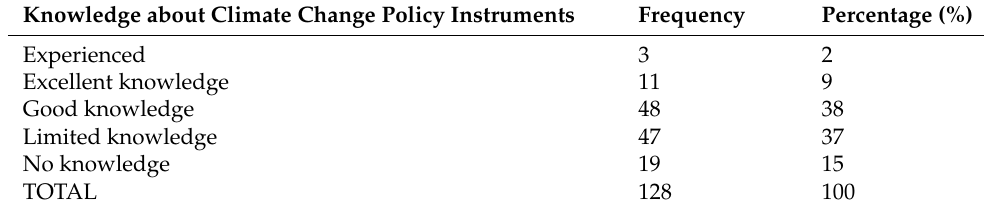
Table A2. Knowledge about climate change policy instruments.